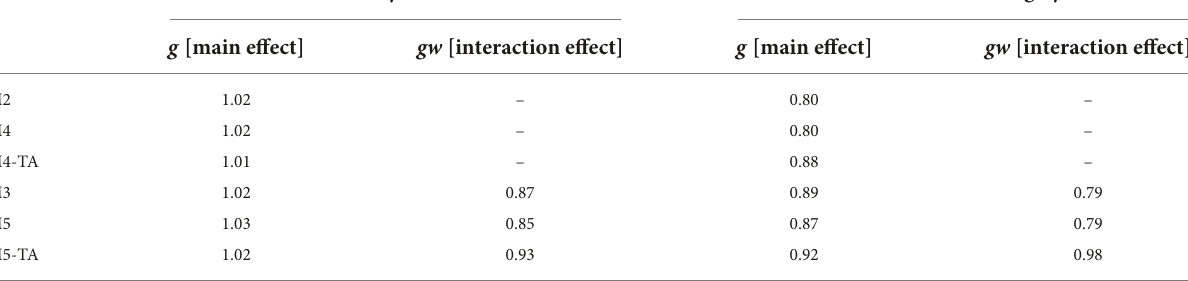
TABLE 7 Slope of regression ( b w , p ) of estimated genetic values with whole information on genetic values with partial information for grain yield in leave-one-year-location-out and leave-one-breeding-cycle-out cross-validations. Models CV1: